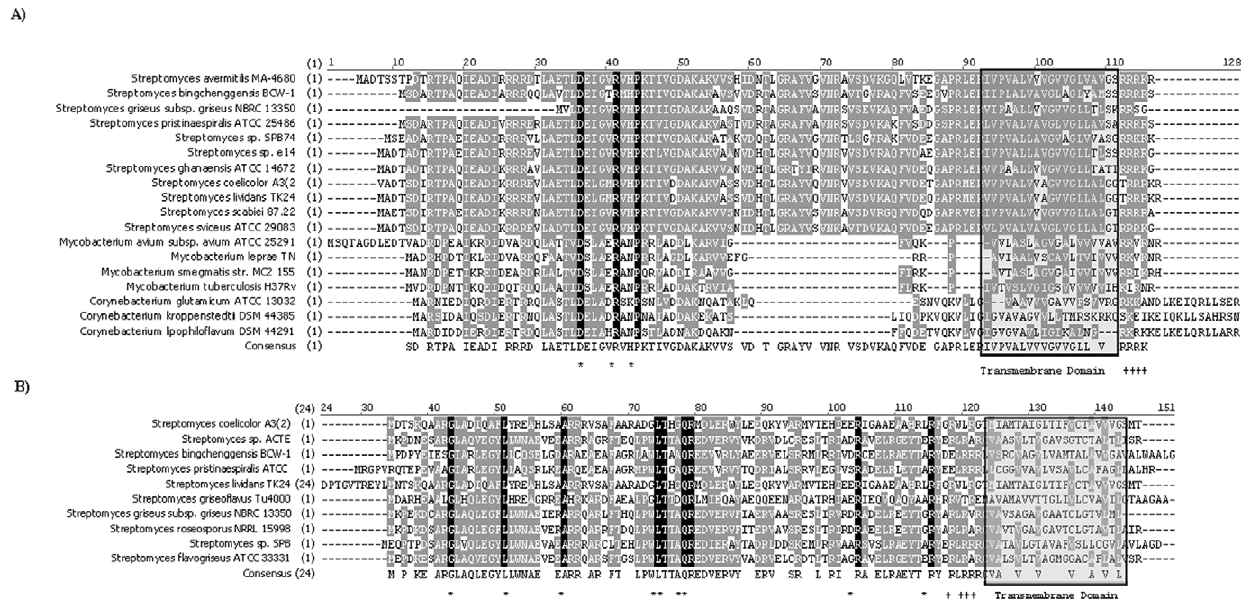
Figure 2. Alignments of predicted tail-anchor membrane proteins. ( A ) SCO2900 from S. coelicolor aligned with various orthologues from other streptomycetes and actinomycetes ( B ) SCO7133 from S. coelicolor aligned with various orthologues from other streptomycetes. The S. lividans extended leader sequence is MGRHRPREDRRPTGTAPTAAPRH . Absolutely conserved residues are shaded black and marked with *, similar residues are shaded grey. Possible topology predicting residues are marked with + and the C-terminal transmembrane domains are boxed and shaded grey.